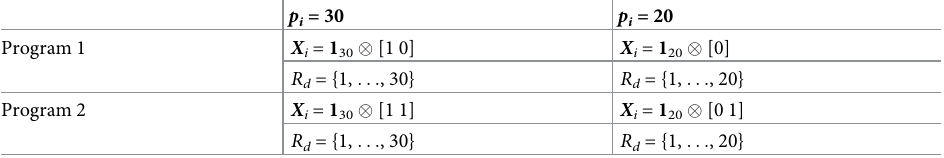
Table 2. Design matrices and patterns of observations for proposed study of smoking cessation programs. p i =